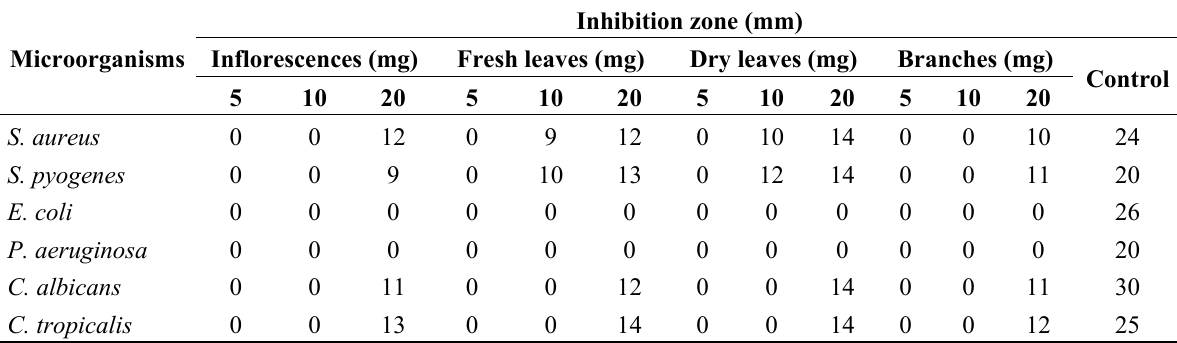
Experiments were done in triplicate and results were mean values. Control: chloramphenicol (1 μ g/mL) for bacteria or fluconazole (20 μ g/mL) for the yeast. Table 3. Minimal inhibitory concentrations of the essential oils of Eremanthus erythropappus .